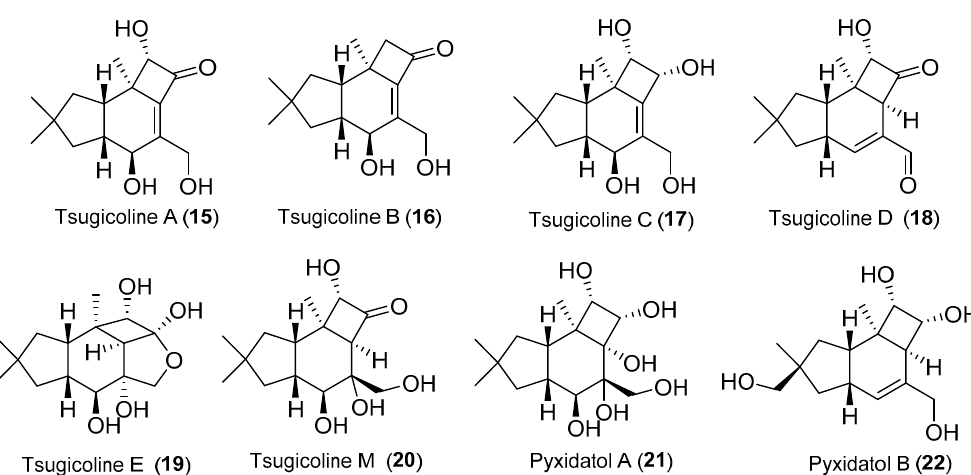
Figure 6. Structures of tsugicolines 15 – 20 and pyxidatols A ( 21 ) and B ( 22 ) isolated from the Laurilia and Clavicorona genera of fungi.